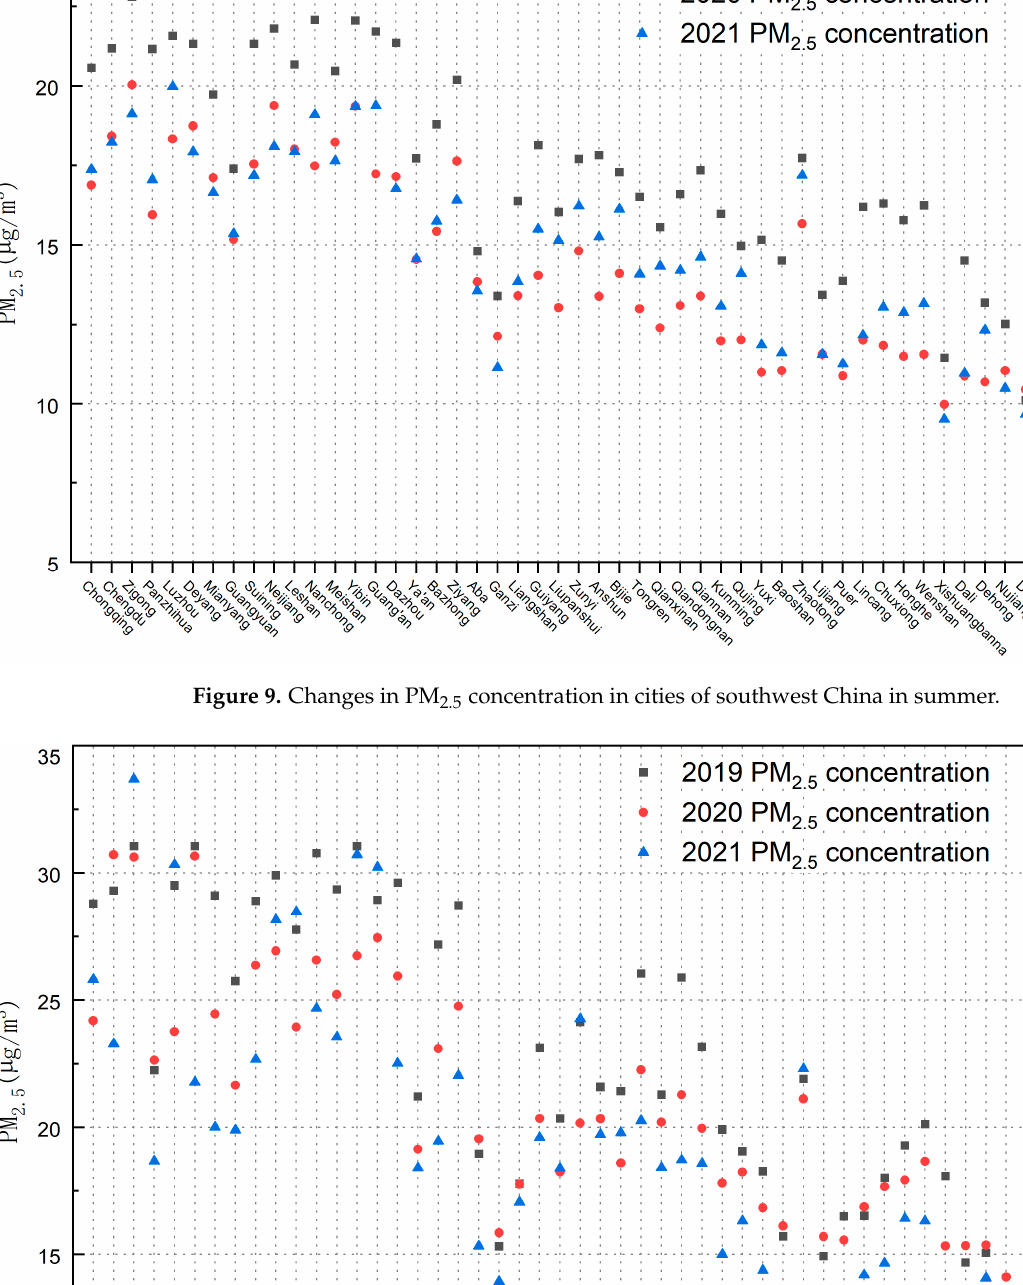
12 of 19 Figure 8. Changes in PM 2.5 concentration in cities of southwest China in spring. The changes in summer PM 2.5 concentrations are shown in Figure 9. The concentra- tions in Chongqing, Sichuan, Guizhou, and Yunnan decreased by 11.8%, 14.8%, 16.6%, and 10.1%, respectively, in the summer of 2020 as compared with that in the same period in 2019 (with an average decrease of 13.4%) and increased by 8.9%, 11.2%, 18.3%, and 4.6%, respectively, in 2021 as compared with that in 2020. From the perspective of spatial distri- bution, the southwest region in summer 2019 showed a distribution of low west and high